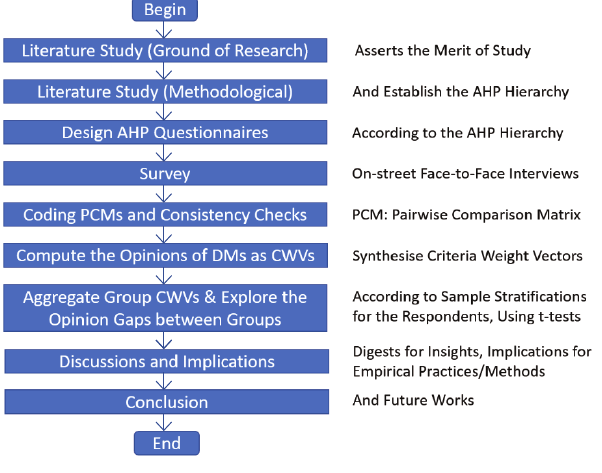
Figure 2. A summary of the research fl